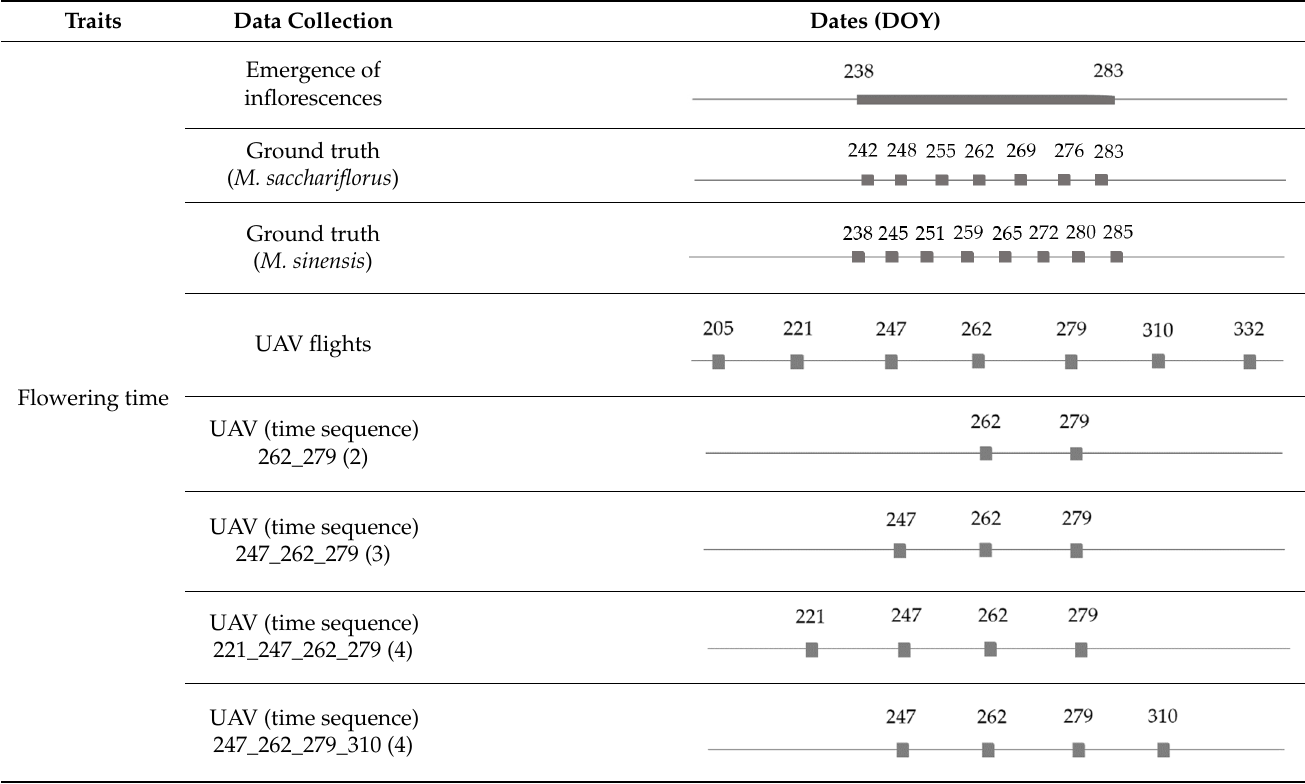
Table 1. Timing of data collection in the field: ground-truthing in the trials and UAV flights through- out the season considered for the CNN modelling setup.